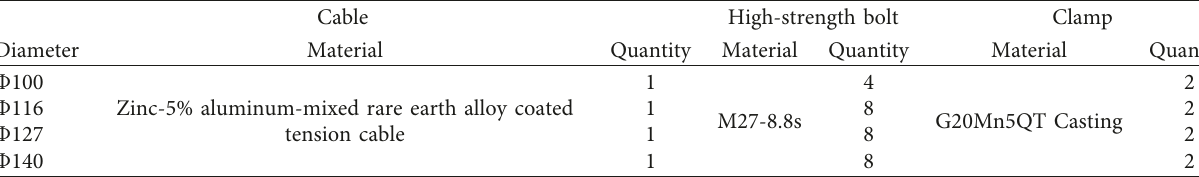
Table 2: Number and materials of the specimens.